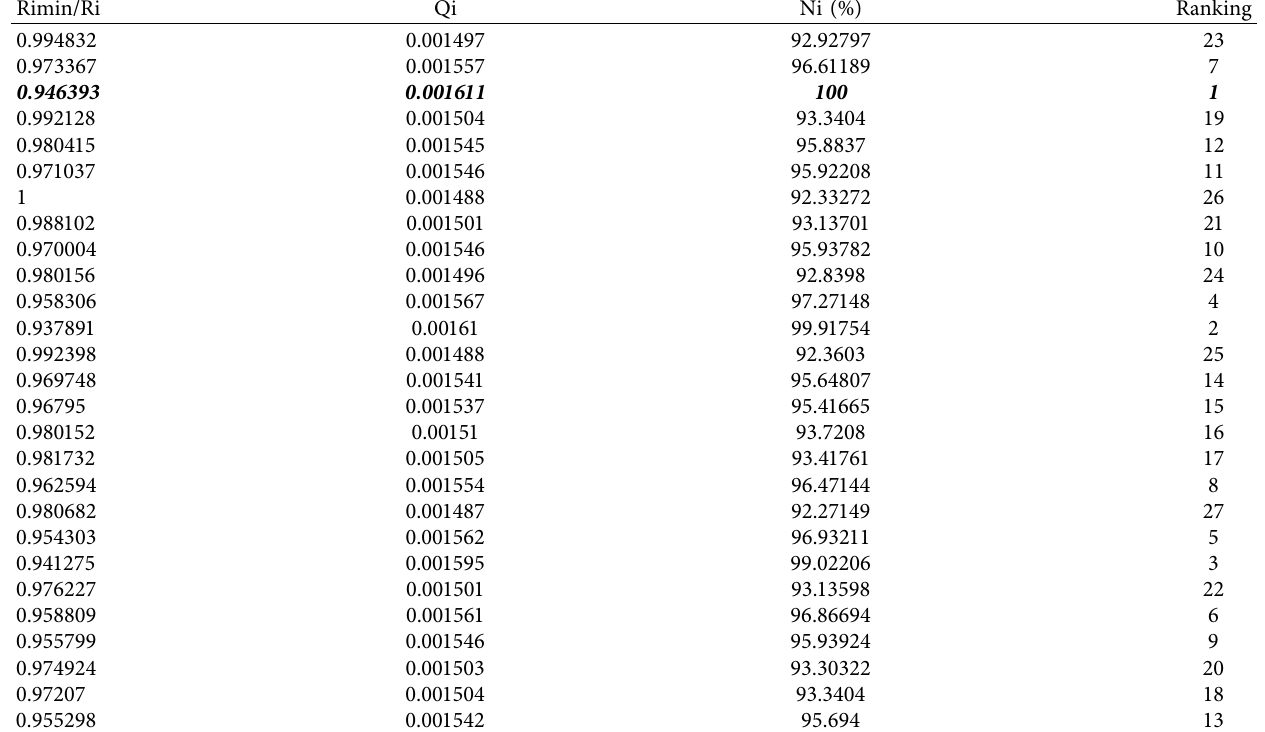
Table 12: Optimal criteria and